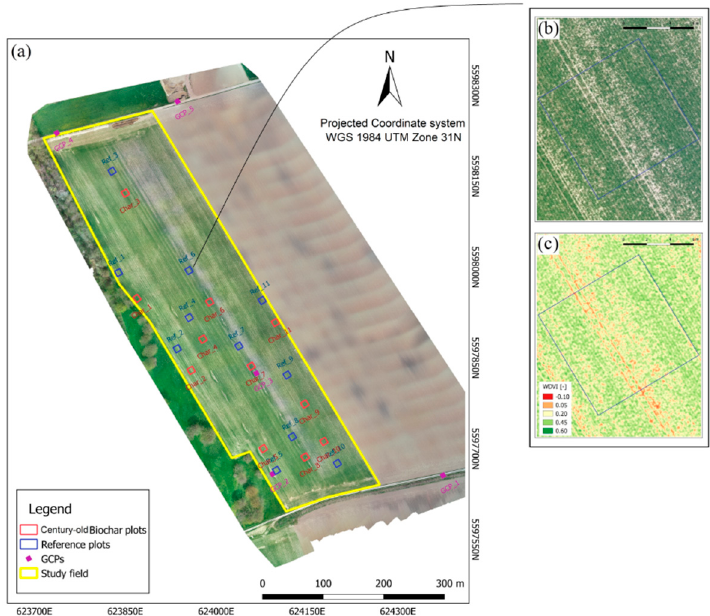
Figure 1. ( a ) A schematic layout of the experimental pairs (reference versus century-old biochar plots) in the winter wheat field and distribution of the ground control points. Background image corresponds to the Red-Green-Blue (RGB) orthomosaic captured by the unmanned aerial vehicle on the 16 April 2019. The right magnified windows present an example of a plot (reference plot 5) for visual RGB ( b ) and multispectral weighted difference vegetation index ( c ) monitored on 16 April 2019.